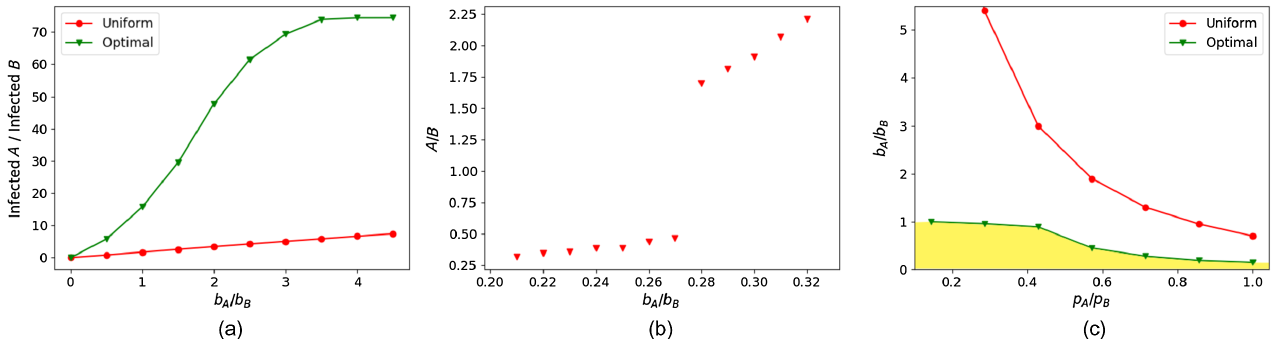
FIG. 7. Optimized competitive scenario on the Lesmis network. (a) Ratio of nodes infected by processes A and B after T ¼ 5 time steps for a given initial budget ratio b A =b B . The infection probabilities used are α A ¼ α B ¼ 0 . 5 . The green curve represents the ratio in the case of DMP-optimized deployment of the A budget, while the red curve represents the uniform deployment case. (b) Fast transition P P N N P i T Þ = P k T Þ for infection probabilities α 0 . 5 and α 0 . 7 and time window in the ratio of expected infected statuses A ¼ B ¼ B ð i ¼ 1 A ð k ¼ 1 1 , and the budget deployment for A is optimized using DMP. (c) Interplay between infection T ¼ 5 . The budget for B is fixed at b B ¼ parameter values and budget allocated to each of the processes on the Lesmis network. The x axis represents the ratio between infection parameters α A = α B and the y axis the ratio between budgets b A =b B . The green line represents values for which the two processes have equal probabilities in the network at T ¼ 5 when DMP-optimized deployment of resource A is used; the red line represents the same line for uniform deployment. Results are averaged over five randomly chosen initial positions for the seed of B